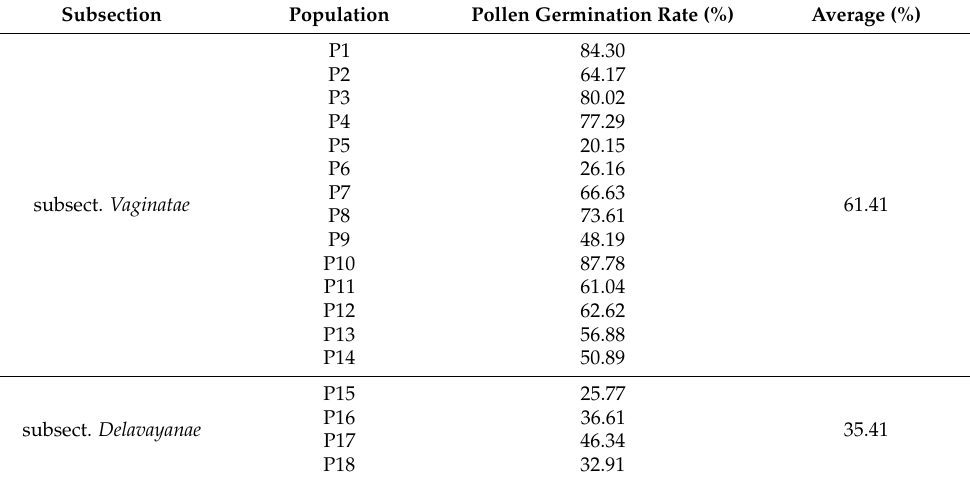
Table 5. The germination rate of different peony pollen in